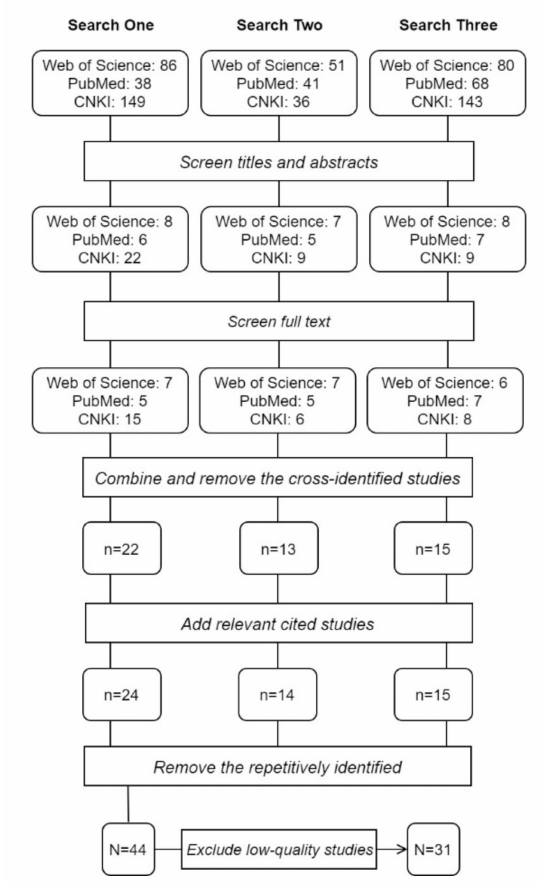
Figure 2. The flowchart of the systematic searches and